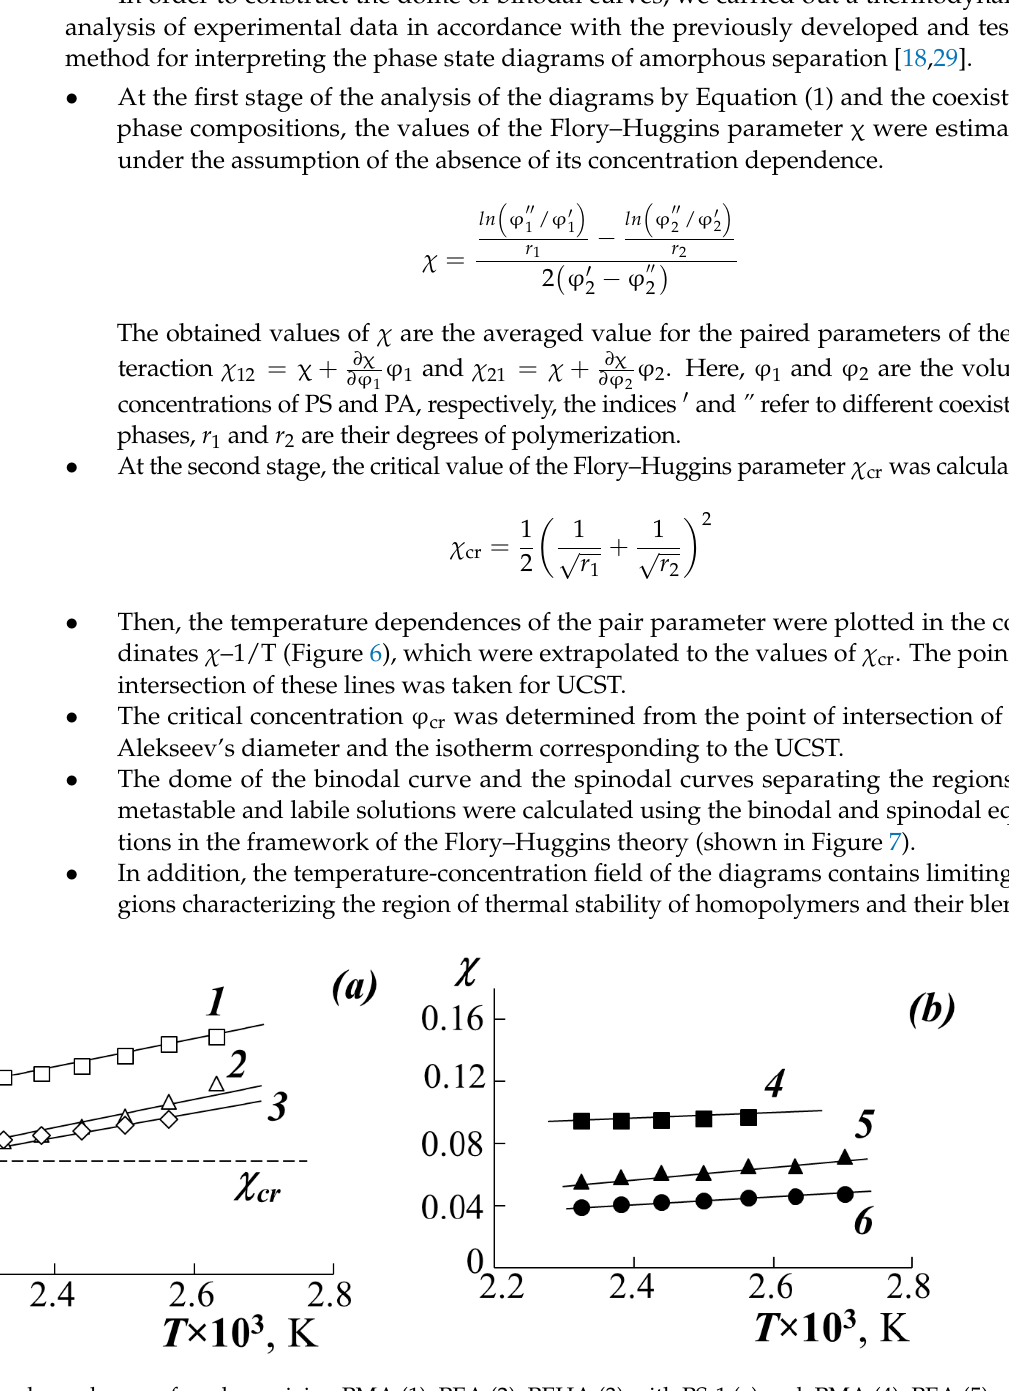
Figure 6. Temperature dependences of χ when mixing PMA (1), PEA (2), PEHA (3) with PS-1 ( a ) and, PMA (4), PEA (5), PBA (6) with PS-2 ( b ).